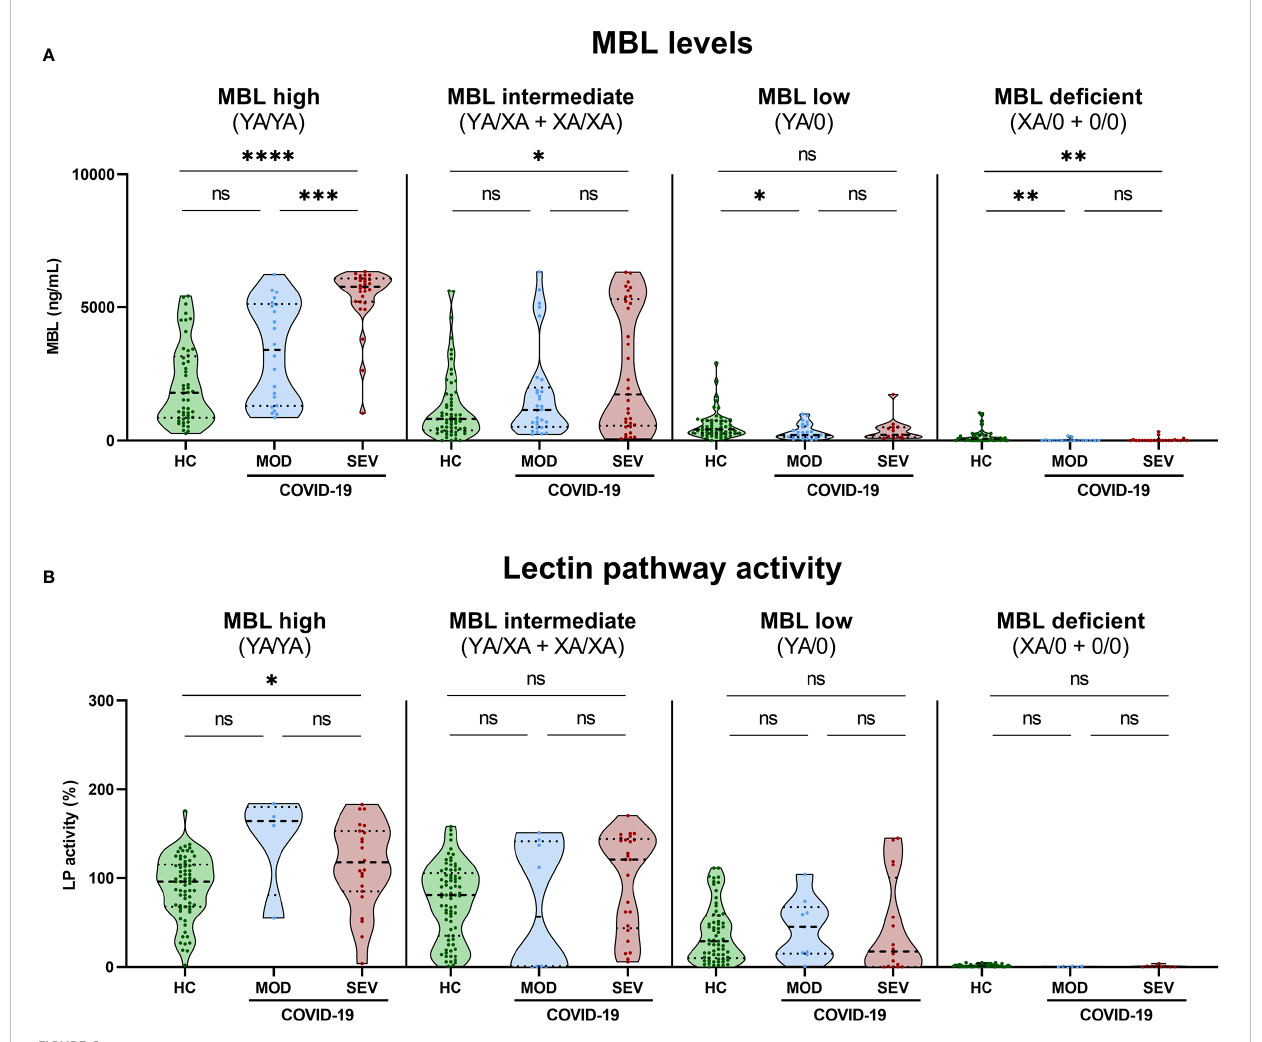
FIGURE 6 MBL levels (CAM) and Lectin pathway activity (BUD) in healthy controls and COVID-19 patients, strati fi ed according to MBL2 genotype groups and disease severity. Short MBL2 haplotype combinations were merged into four different groups: 1) MBL high (YA/YA), 2) MBL intermediate (YA/XA+XA/ XA), 3) MBL low (YA/0 (including YA/YB, YA/YC and YA/YD)), and 4) MBL de fi cient (XA/0+0/0 (including 0/0 for allele A, XA/YB, XA/YC and XA/YD)). After genetic grouping, groups were furthermore strati fi ed according to disease severity, and MBL (A) as well as Lectin pathway activity levels (B) were compared within groups using ANOVA with Dunn ’ s multiple comparison post-hoc test. Asterisks indicate signi fi cant results between severity groups (* p<0.05, ** p<0.01, *** p<0.001, **** p<0.0001). HC, Healthy controls; HOSP, Hospitalized patients not requiring ventilation; HOSP+O 2 , Hospitalized patients requiring ventilation; ICU, Intensive care unit patients; MOD, moderate patients group; SEV, severe patients group; LP, lectin pathway; ns, non-signi fi